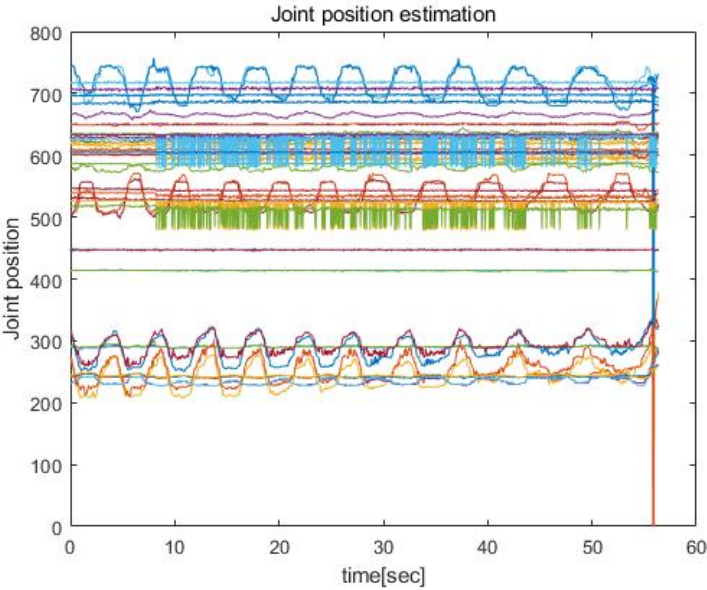
Figure 5. Estimated x and y positions of 25